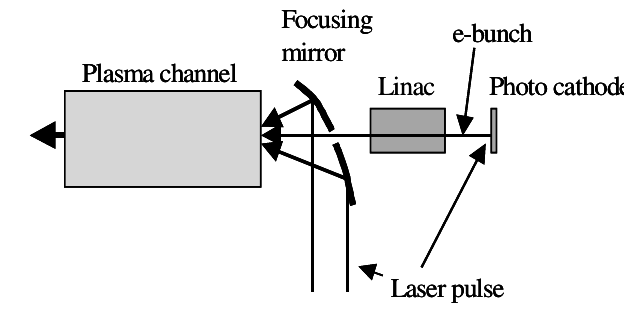
FIG. 7. A possible experimental setup for demonstration of extremely short e -bunch